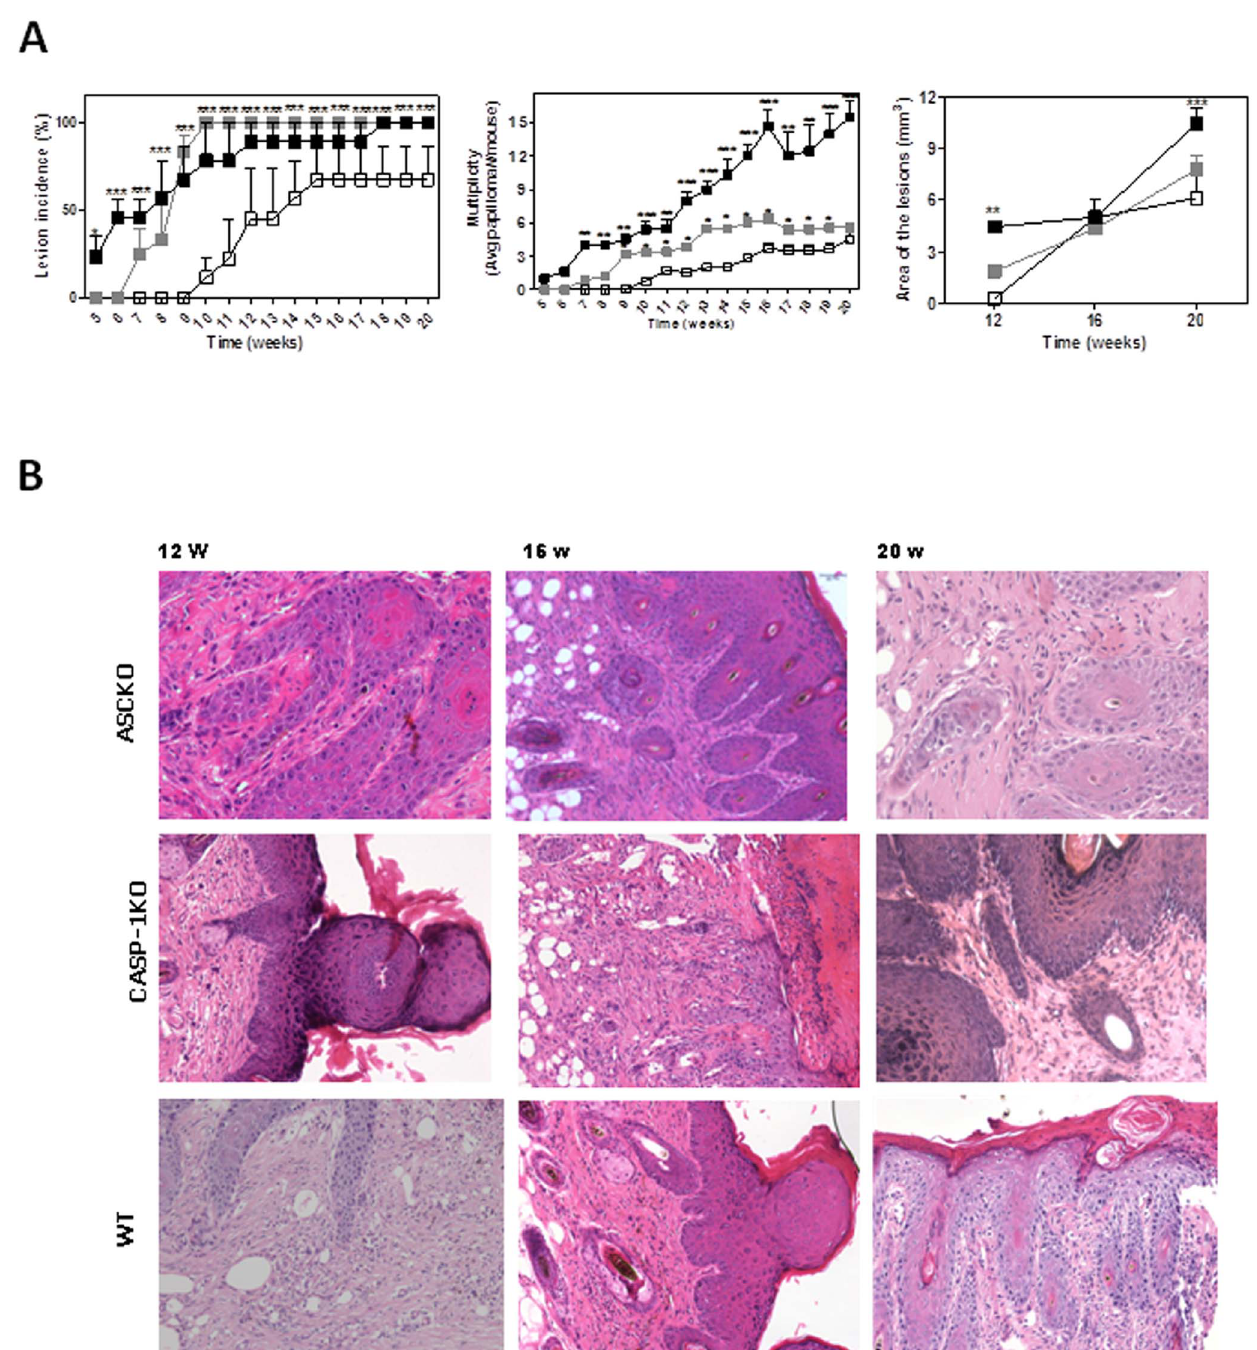
Figure 1. Absence of inflammasome molecules induced an increase of papilloma incidence and volume during SCC development. ASC-KO (gray square), CASP-1-KO (black square) and WT (white square) mice were treated according to a chemical carcinogenic protocol using DMBA and PMA for 20 weeks. (A) The incidence, average number and volume of papillomas were determined. Data shown represent mean 6 SEM; * p # 0.05, ** p # 0.01, *** p # 0.001 compared with WT mice. Representative data are show from at least three independent experiments. (B) Representative haematoxylin and eosin staining of skin section from 12, 16 and 20 weeks after SCC induction. Scale bars represent 50 uM.